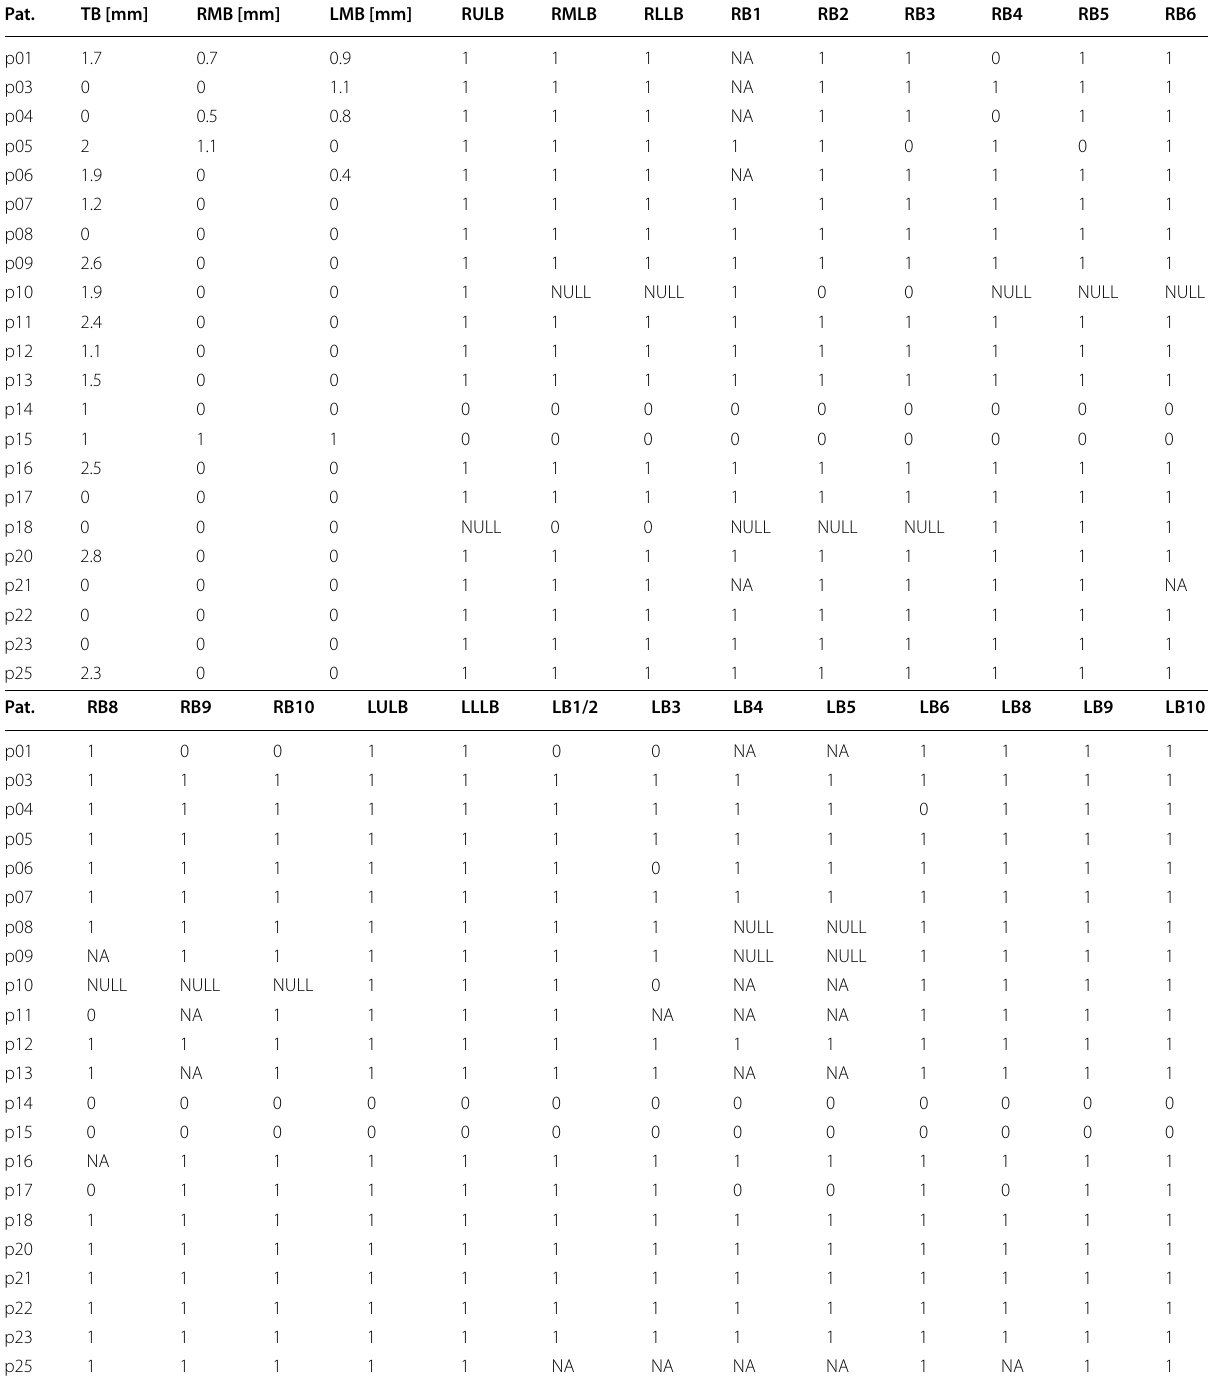
Table 1 Distances, measured in mm, and distance-type quantities of corresponding anatomical localisations (see detailed explanation in the text). Segmental bronchi were labelled according to Boyden’s nomenclature